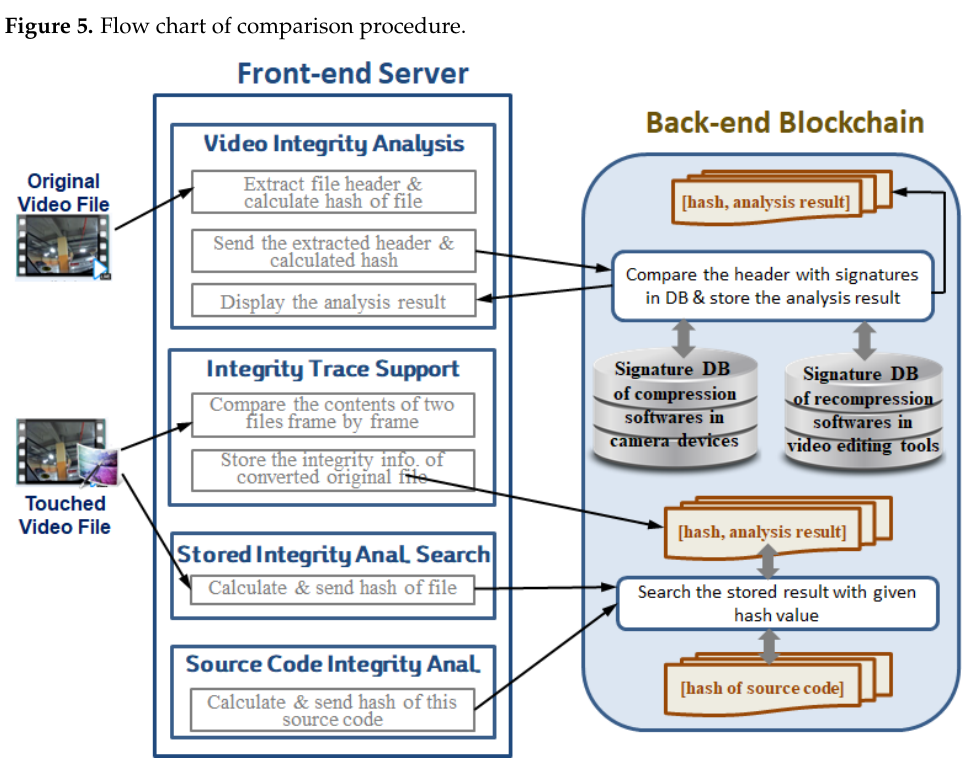
Figure 6. Detailed structure of integrity preservation